Question: Based on the figure, does the quantity rise or fall?
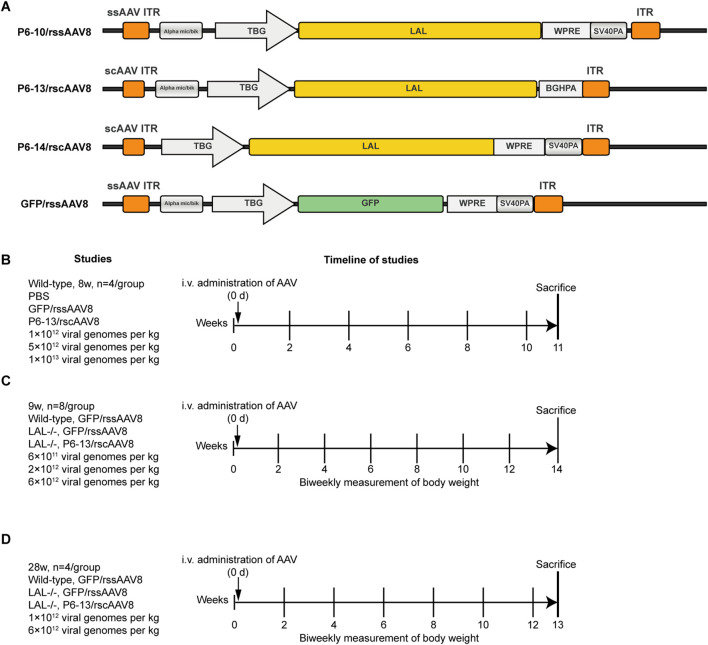
Answer: increasing